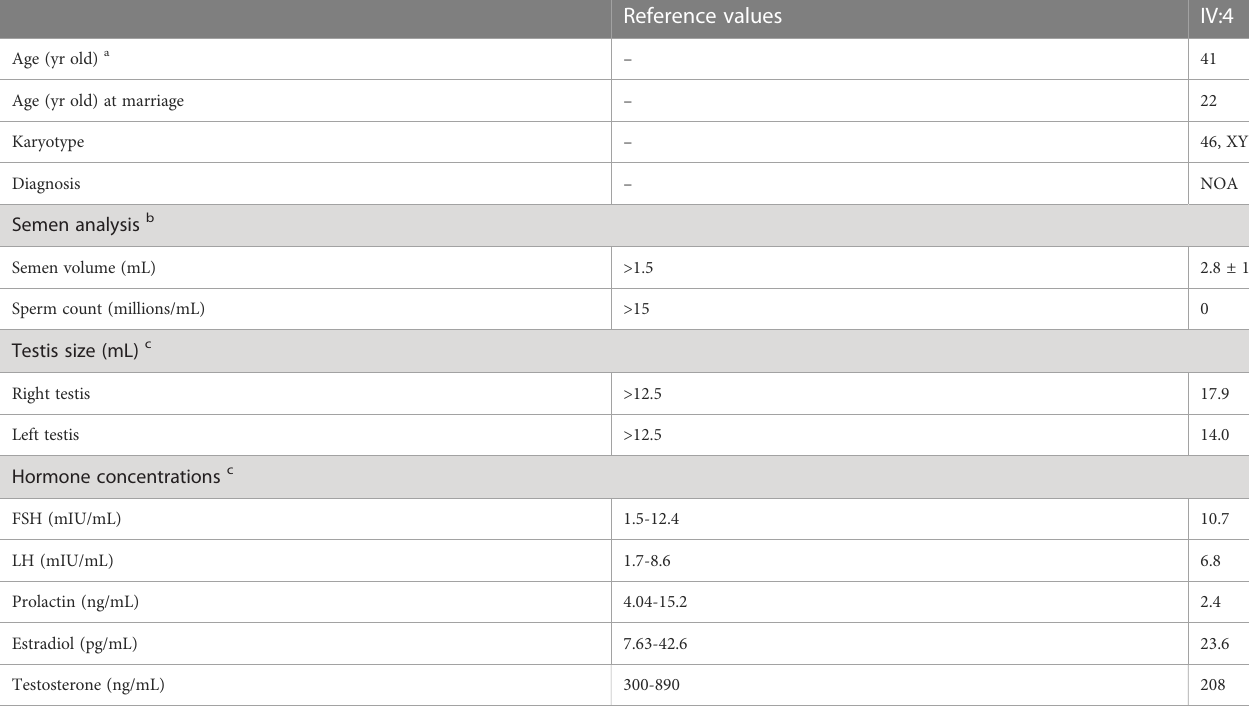
TABLE 2 Clinical characteristics of the male